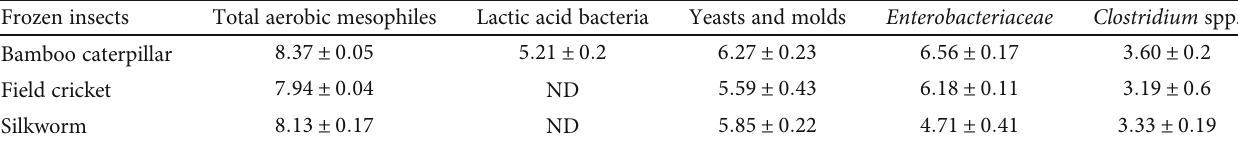
Table 1: Microbial analysis of frozen insects.